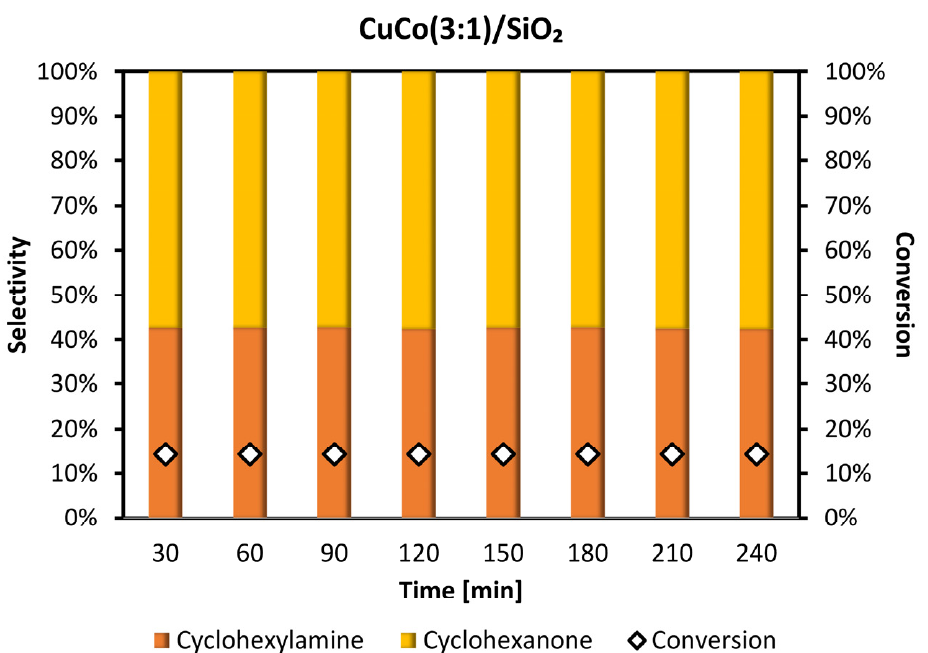
Figure 16. Catalytic hydrogenation of nitrocyclohexane in gas flow conditions with CuCo(3:1)/SiO 2 .